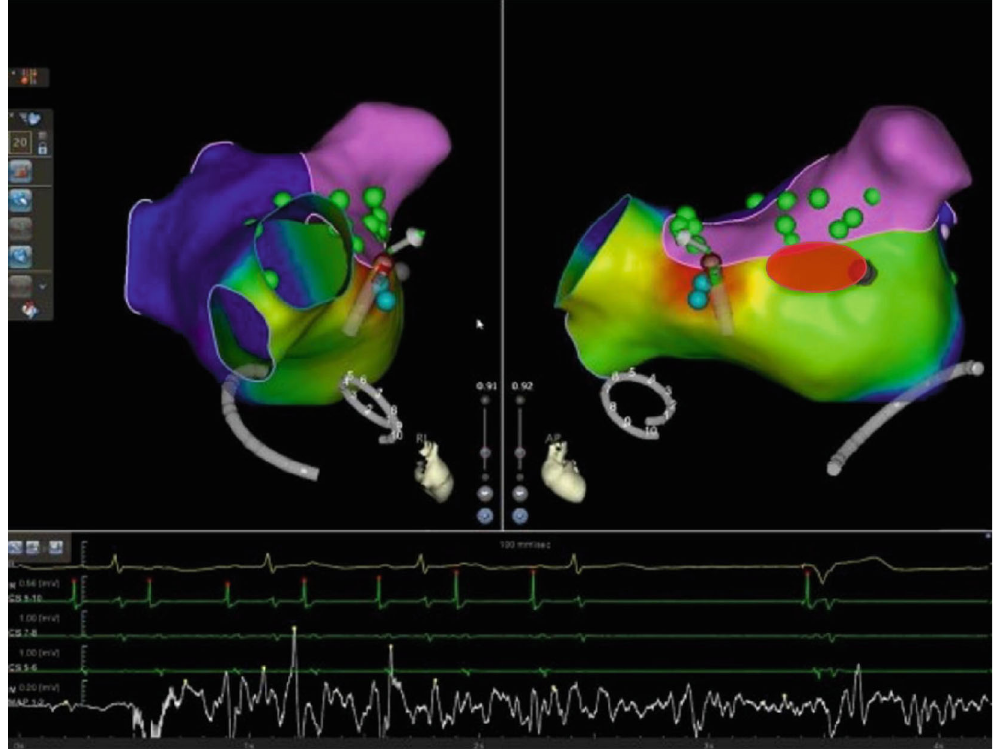
Figure 2: Termination of the atrial fl utter. Activation mapping showed the mechanism of the atrial fl utter to be focal (atrial activation spanning 145ms, less than one-half of the cycle length of the atrial fl utter, which was 330ms); the earliest point of activation is on the left side of the interatrial septum. A linear area of double potentials with a gap in the middle can be seen from the base of the LAA to the right PV antrum (green dots). The gap is the area of the earliest activation. Radiofrequency energy delivery at the gap (35 W, 3 seconds) terminated the atrial fl utter. A paced signal can also be seen from the temporary pacemaker inserted for protection during the procedure. Red circle marked the area ablated during CFAE